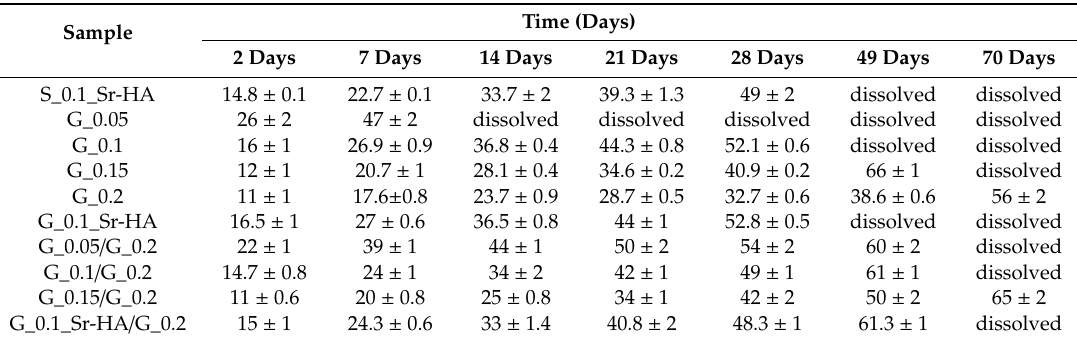
Table 4. Gelatin release (w %) 1 .